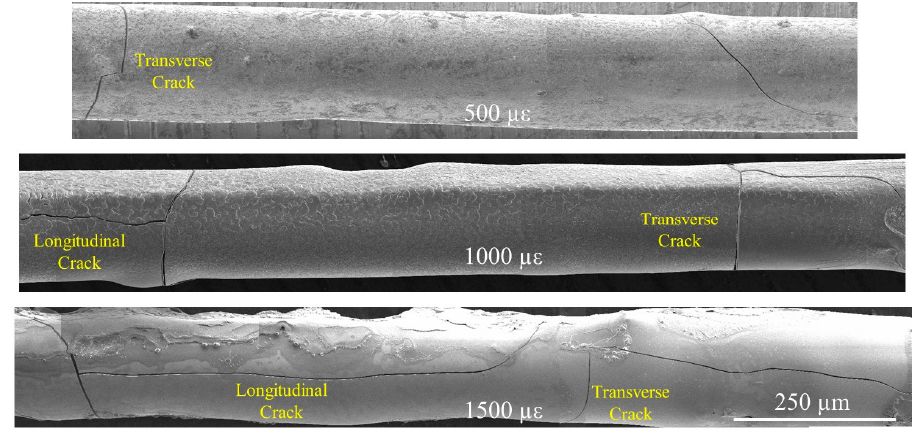
Figure 6. Stitched SEM images along axial direction of the fiber showing two adjacent transverse cracks at each strain.